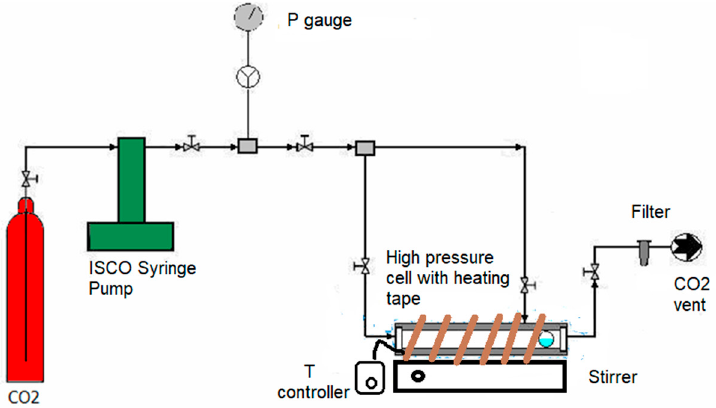
Figure 1. Sketch of the reacting system for NMC of styrene and divinylbenzene in scCO 2 .